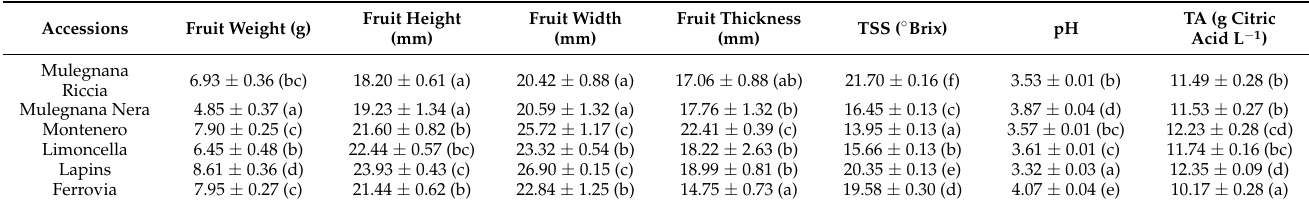
Table 1. Morpho-physiological and physicochemical parameters collected from the four sweet cherry accessions (Mulegnana Riccia, Mulegnana Nera, Montenero and Limoncella) compared to two standard cultivars (Lapins and Ferrovia). Data represent means ± SD. The same letters indicate non-significant differences (Tukey test) between